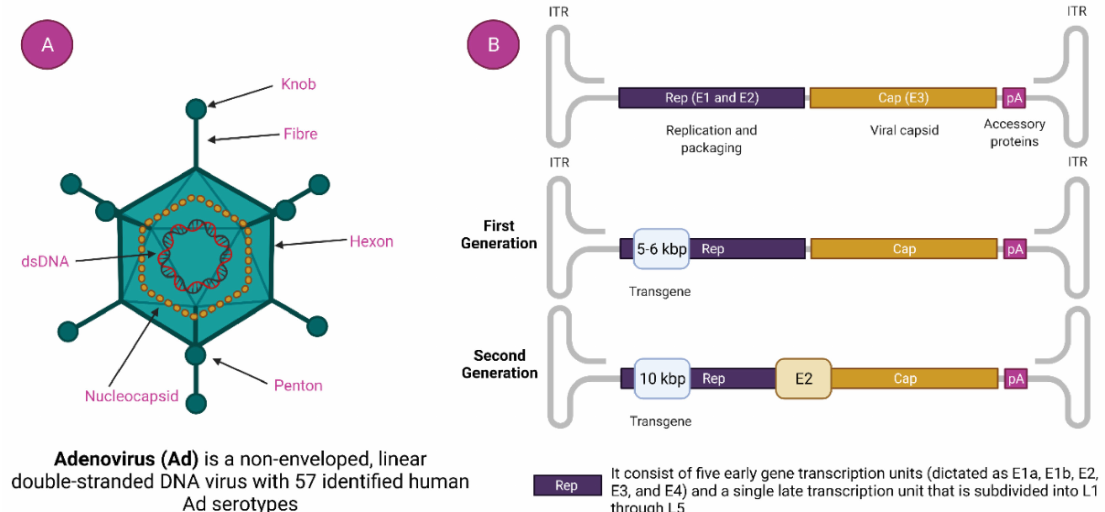
Figure 2. Adenovirus and adenovirus-based vector. ( A ). Adenovirus Structure and ( B ). Generation of Adenoviral